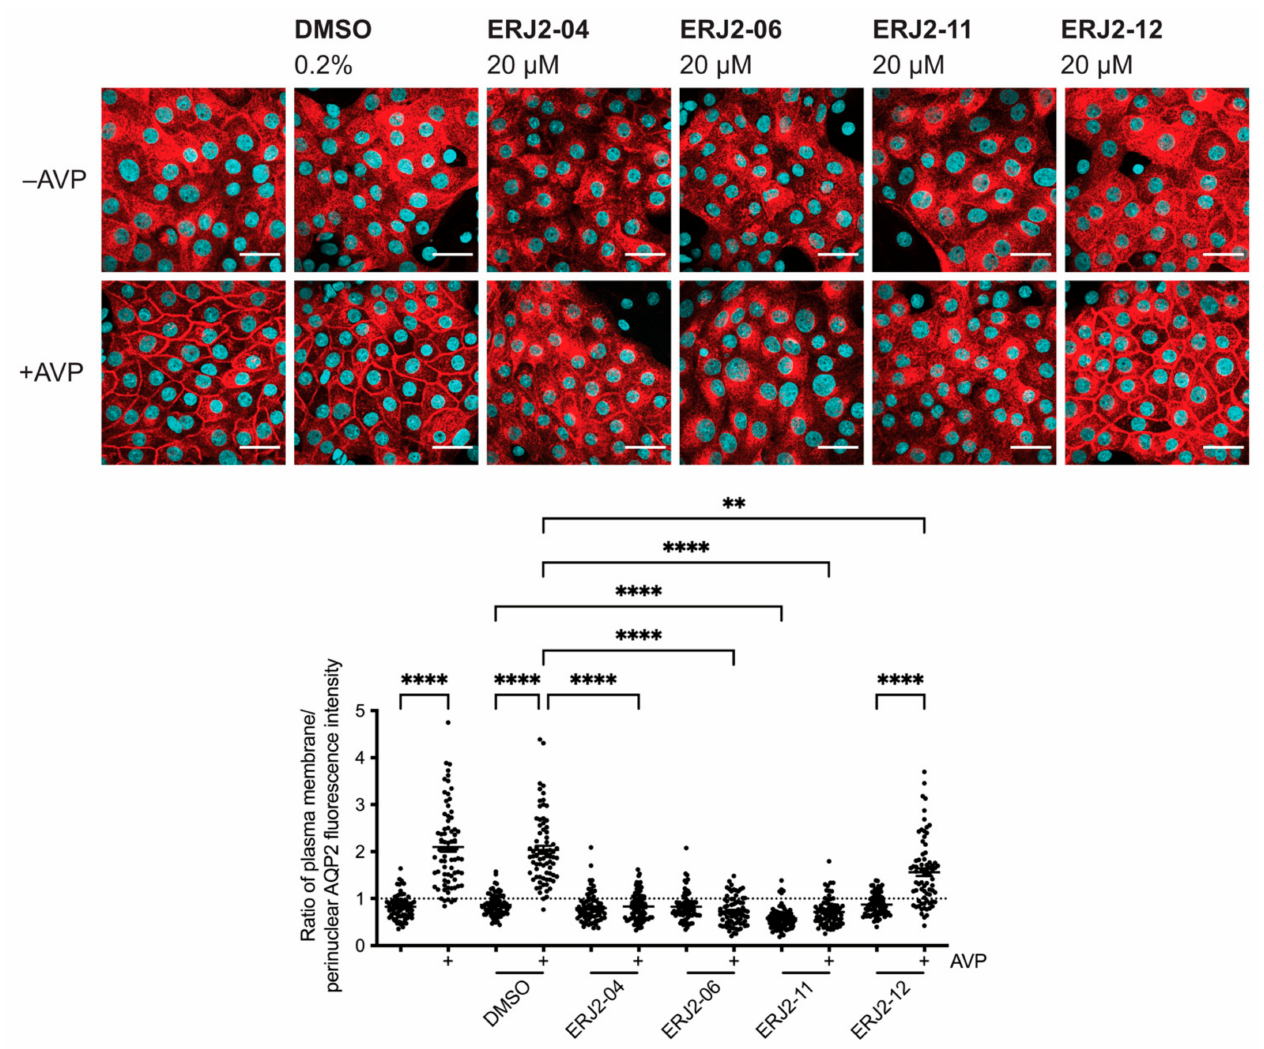
Figure 4. Aurora-A inhibitor I derivatives inhibit the AVP-induced redistribution of AQP2 to the plasma membrane of primary IMCD cells. Cells were left untreated or treated with DMSO (0.2%, 1 h) or compound (20 µ M, 1 h) alone or in combination with arginine-vasopressin (AVP; 100 nM, 30 min). AQP2 was detected by immunofluorescence microscopy and quantified as described in the legend of Figure 1. Shown are representative images of three independent experiments; scale bar 30 µ m. Ratios > 1 indicate a predominant localization at the plasma membrane. Shown are means ± SEM of three independent experiments with a total of 75 cells per condition. Statistically significant differences compared to DMSO-treated control cells are indicated, **** p < 0.0001, ** p <